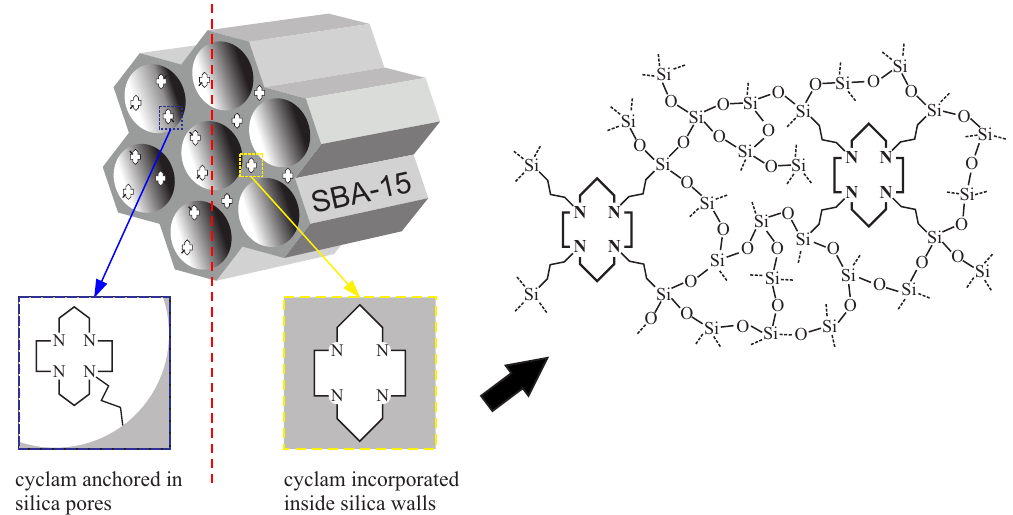
Figure 23. A diagram of the structure of silica modified by cyclam (1,4,8,11-Tetraazacyclotetradecane) molecules: anchored inside silica pores (left side) and incorporated inside the walls along with the schematic molecular structure (right side – dashed lines represent the continuation of the